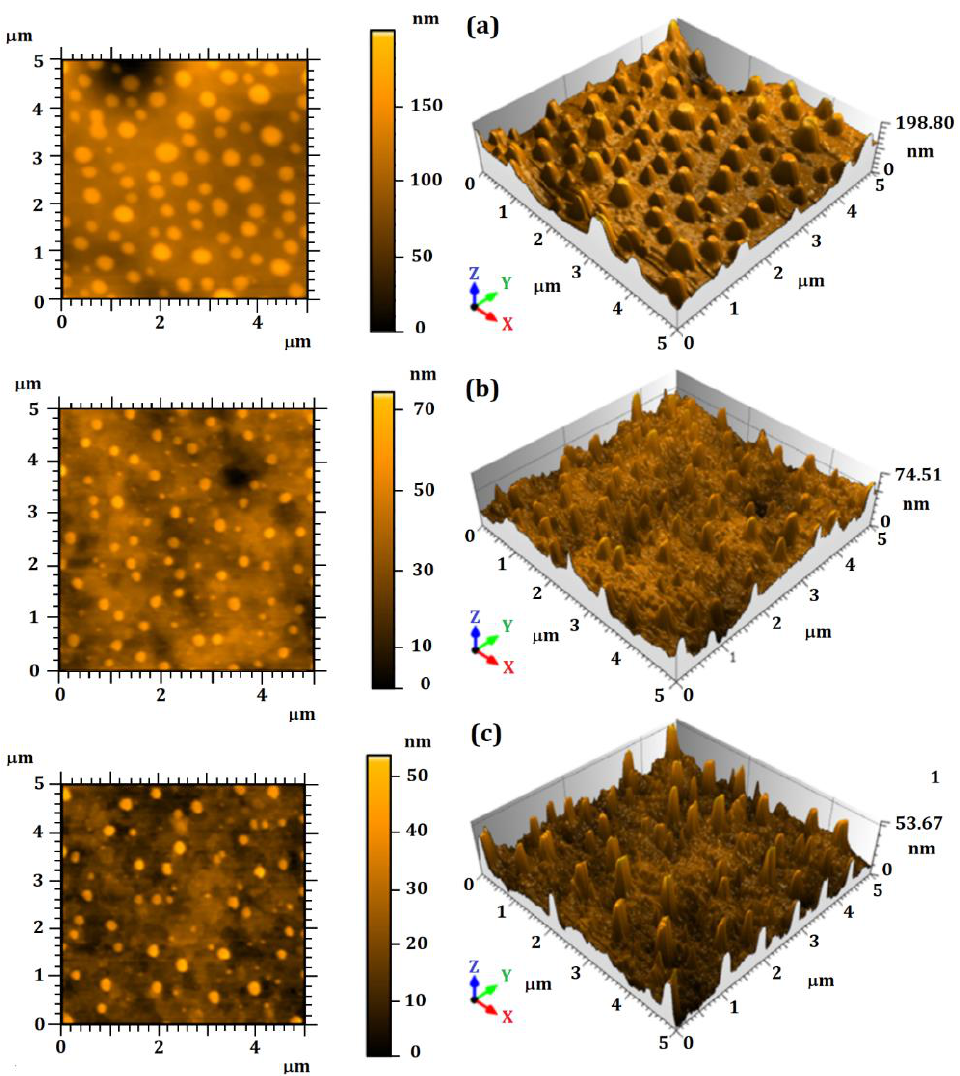
Figure 1. Two-dimensional and three-dimensional AFM micrographs: ( a ) unloaded particles (P 0 ), ( b ) loaded particles using 500 µg·mL −1 of essential oil (P 500 ), and ( c ) loaded particles using 1000 µg·mL −1 of essential oil (P 1000 ).